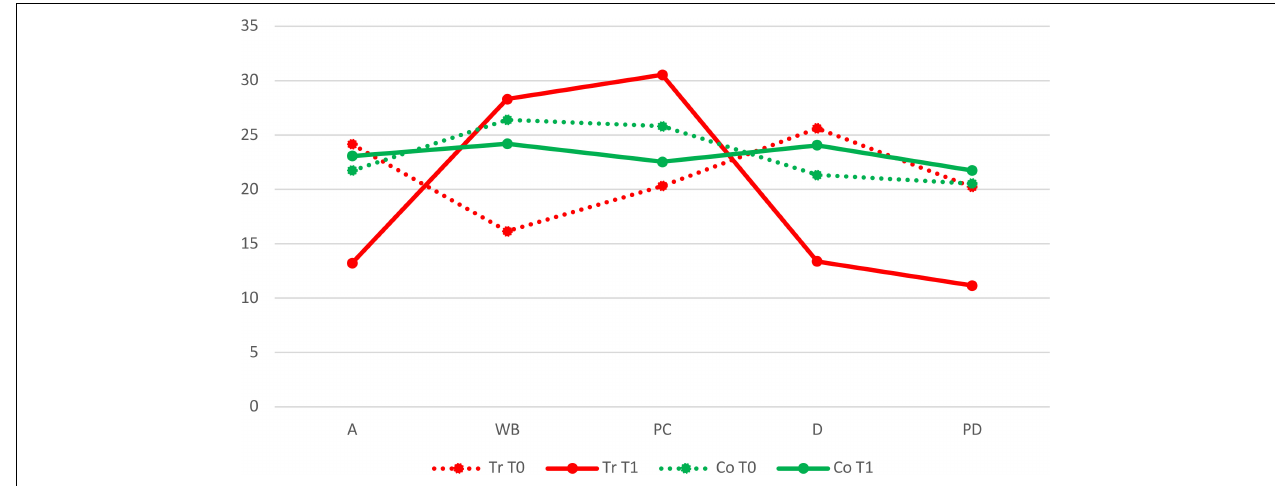
FIGURE 1 | Comparison between the treatment (Tr) and control (Co) groups of patients at T0 and T1 on the Anxiety (A), Well-Being (WB), Perception of a Positive Change (PC), Depression (D), and Psychological Distress (PD) scales.